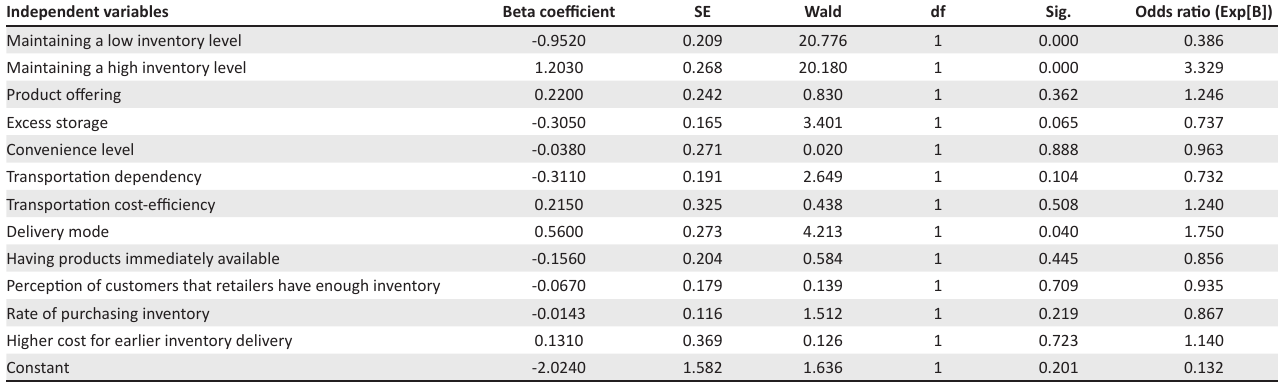
TABLE 6: Independent variables in the equation for the binary logistic regression model with the dependent variable income growth. Independent